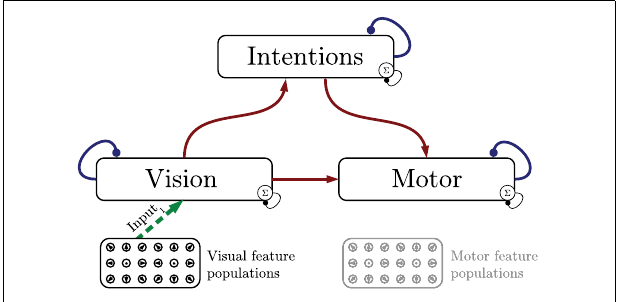
FIGURE 7 | Experiment 2a/b: inference of intentions and motor commands from visually observed movements . Solid lines indicate the propagation of sensory signals (green), cross-modular predictive signals (red), and intramodular predictions (blue). During testing, only the visual sensor is available and fused with the emerging predictions, assuming some uncertainty in sensory information. Intentions are inferred visually, while corresponding motor commands are inferred from vision and the derived intention.